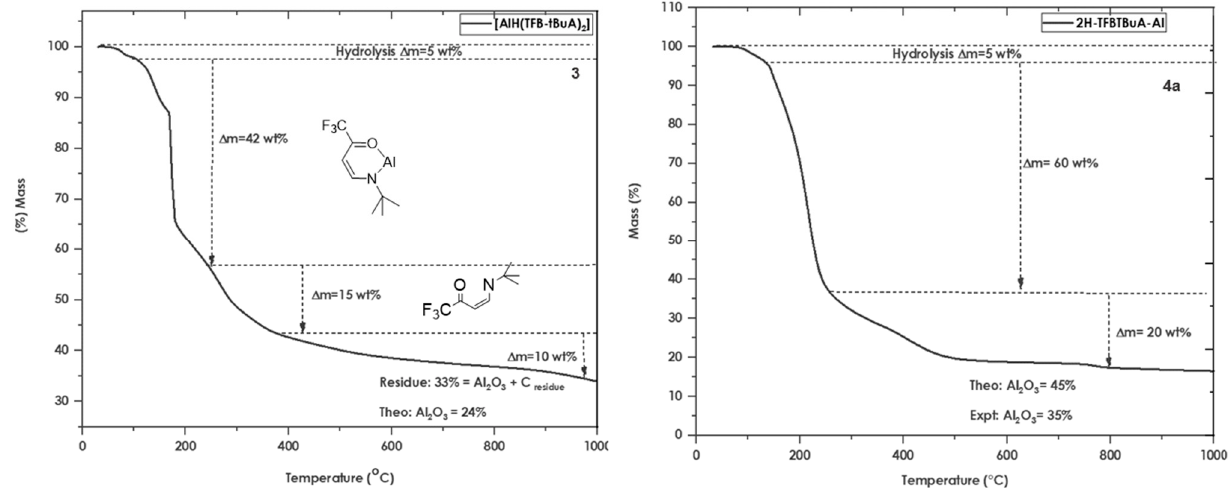
Figure 5. Thermographic curve of compound 3 and 4a in percent as a function of temperature.